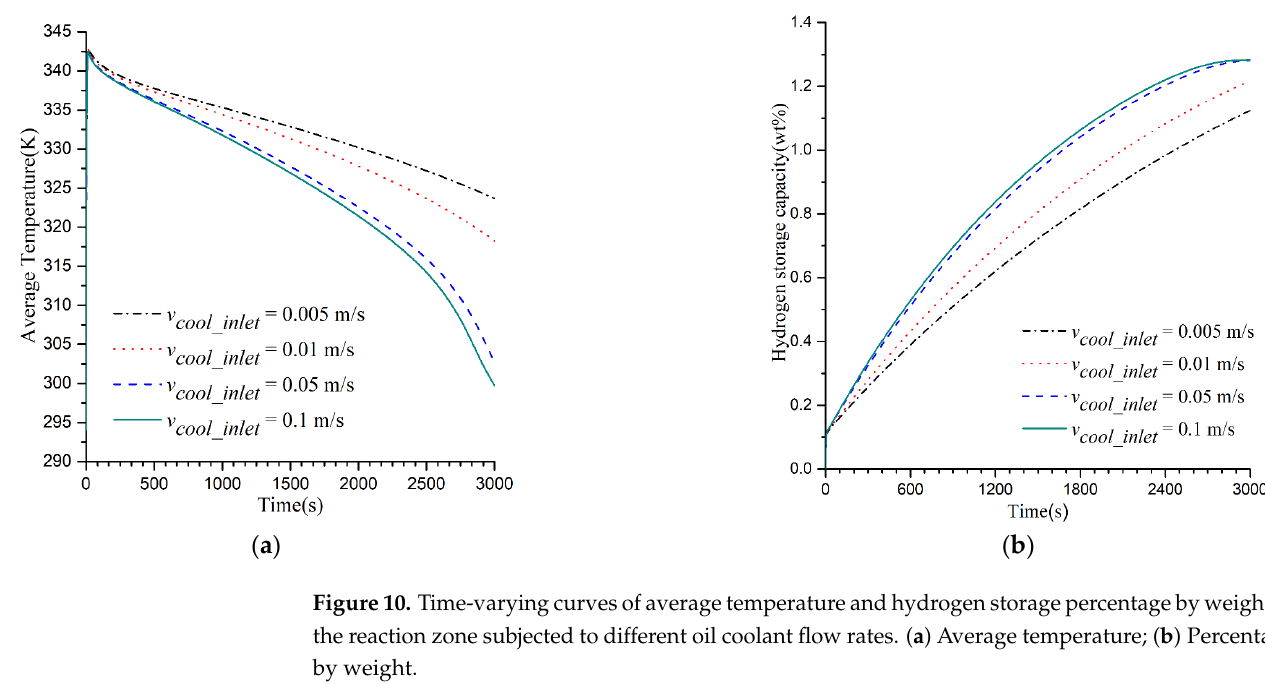
Figure 9. Temperature and hydrogen storage capacity distribution at different times of the reaction tank subjected to an oil coolant flow rate of 0.01 m/s. ( a ) Temperature distribution cloud chart; ( b ) Hydrogen storage capacity distribution cloud chart.